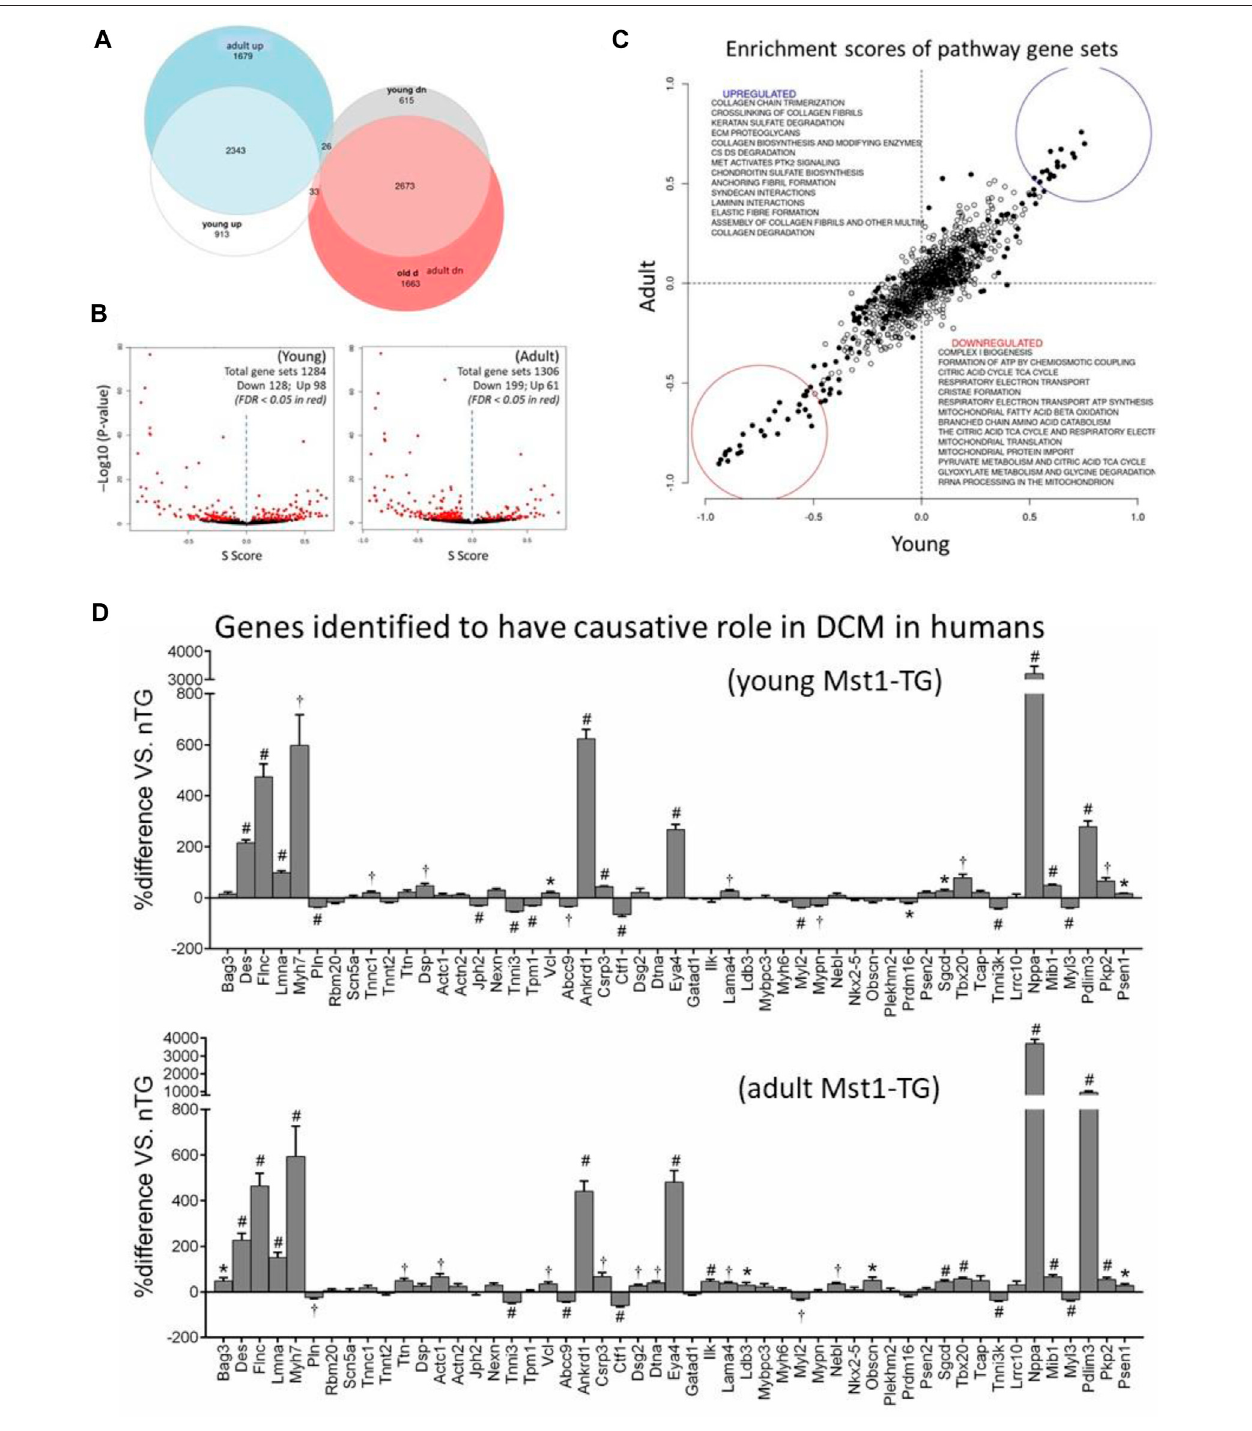
FIGURE 1 | Differentially expressed genes and gene sets by transcriptome pro fi ling in DCM hearts. Cardiotranscriptome pro fi ling of left ventricular tissues from young(3 weeks, n =4pergenotype)andadult(15 weeks, n =6fornTGcontroland n =7forDCM)mice. (A) Eulerdiagramforthedifferentiallyexpressedgenesinyoung and adultDCM hearts. (B) Volcano plotsofdifferentially expressed genesets.Eachdot represents onegenesetwithsetsizeranging from10to1697; (C) Scatterplotof Enrichment scores of pathway gene sets showing consistency in up or downregulated gene sets between young and adult DCM hearts relative to respective control. Pearson R = 0.91 and Spearman R = 0.85. (D) Expression of 51 genes implicated as causal genes for human DCM. * p < 0.05, † p < 0.01, # p < 0.001 vs. nTG.